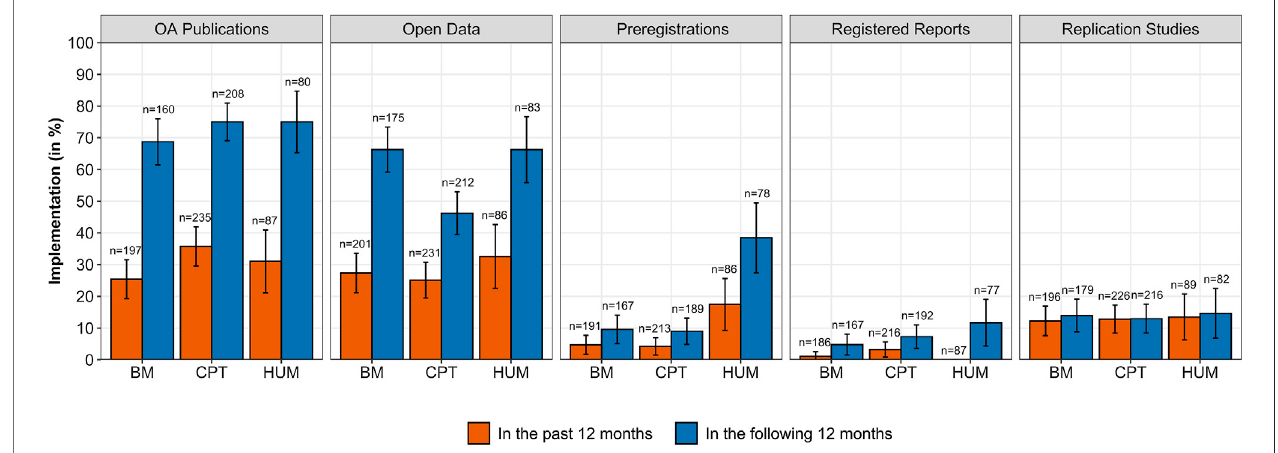
FIGURE4| FrequenciesofimplementationofOSpracticesamongECRsinthepast12 monthsandplannedimplementationinthefollowing12 monthsacrossthe different sections (BM: biology and medicine, CPT: chemistry, physics, and technology, and HUM: humanities). Error bars represent 95% con fi dence intervals (CIs).